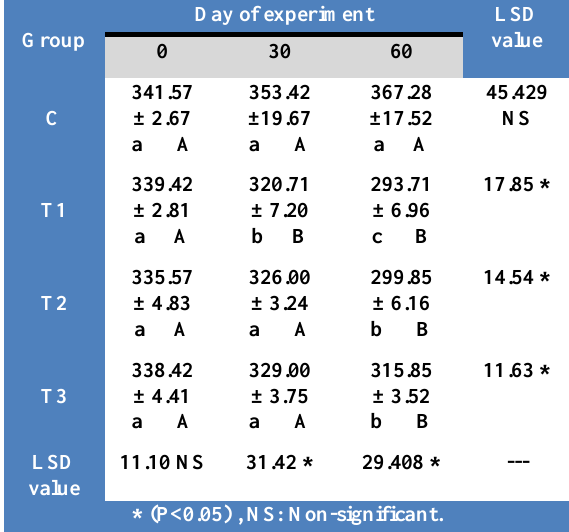
Table, 6: The development of clinical signs of adult male rats during the experiment period in all treated groups compared with control.